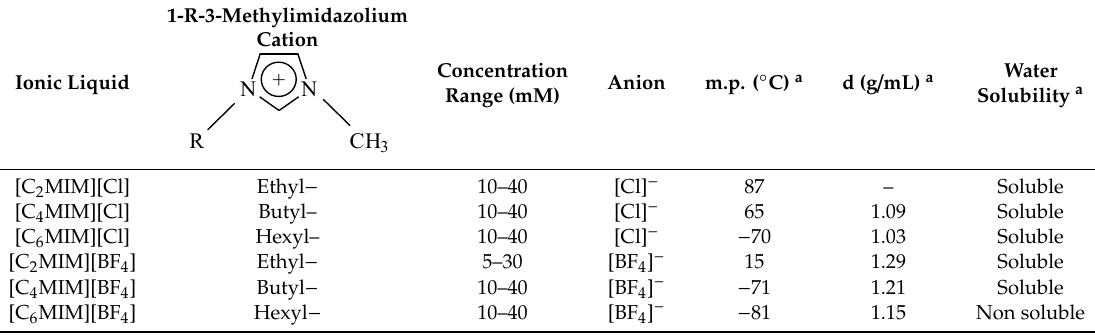
Table 1. Structure and properties of the ionic liquids.